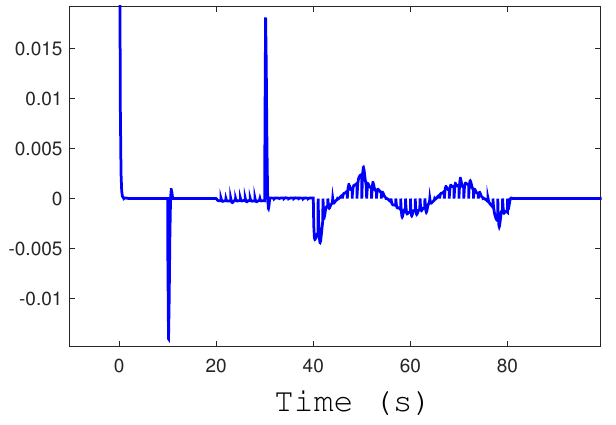
Figure 4. Numerical results: e i ( t )